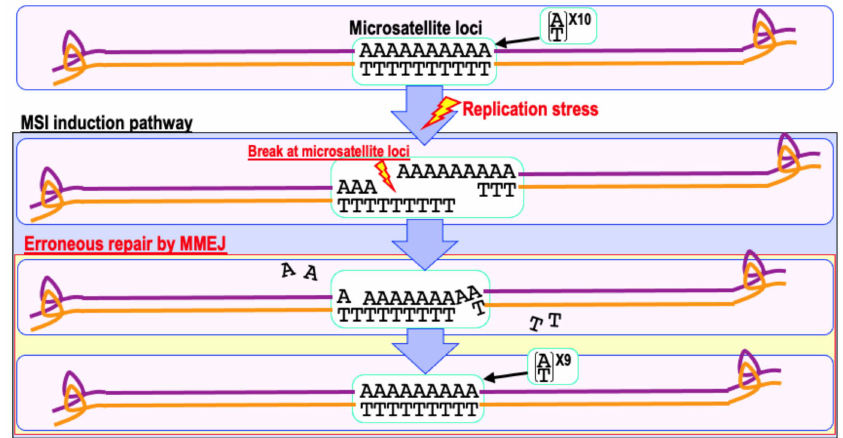
Figure 4. A model of the MSI induction pathway. In an MMR-deficient background, DSBs caused by replication stress at microsatellite loci are effectively repaired by MMEJ. Microsatellite loci can be repeats of a single base or more; thus, erroneous MMEJ can induce multiple types of insertions and deletions of a few bases, i.e., MSI induction, because microhomologous regions can anneal in multiple